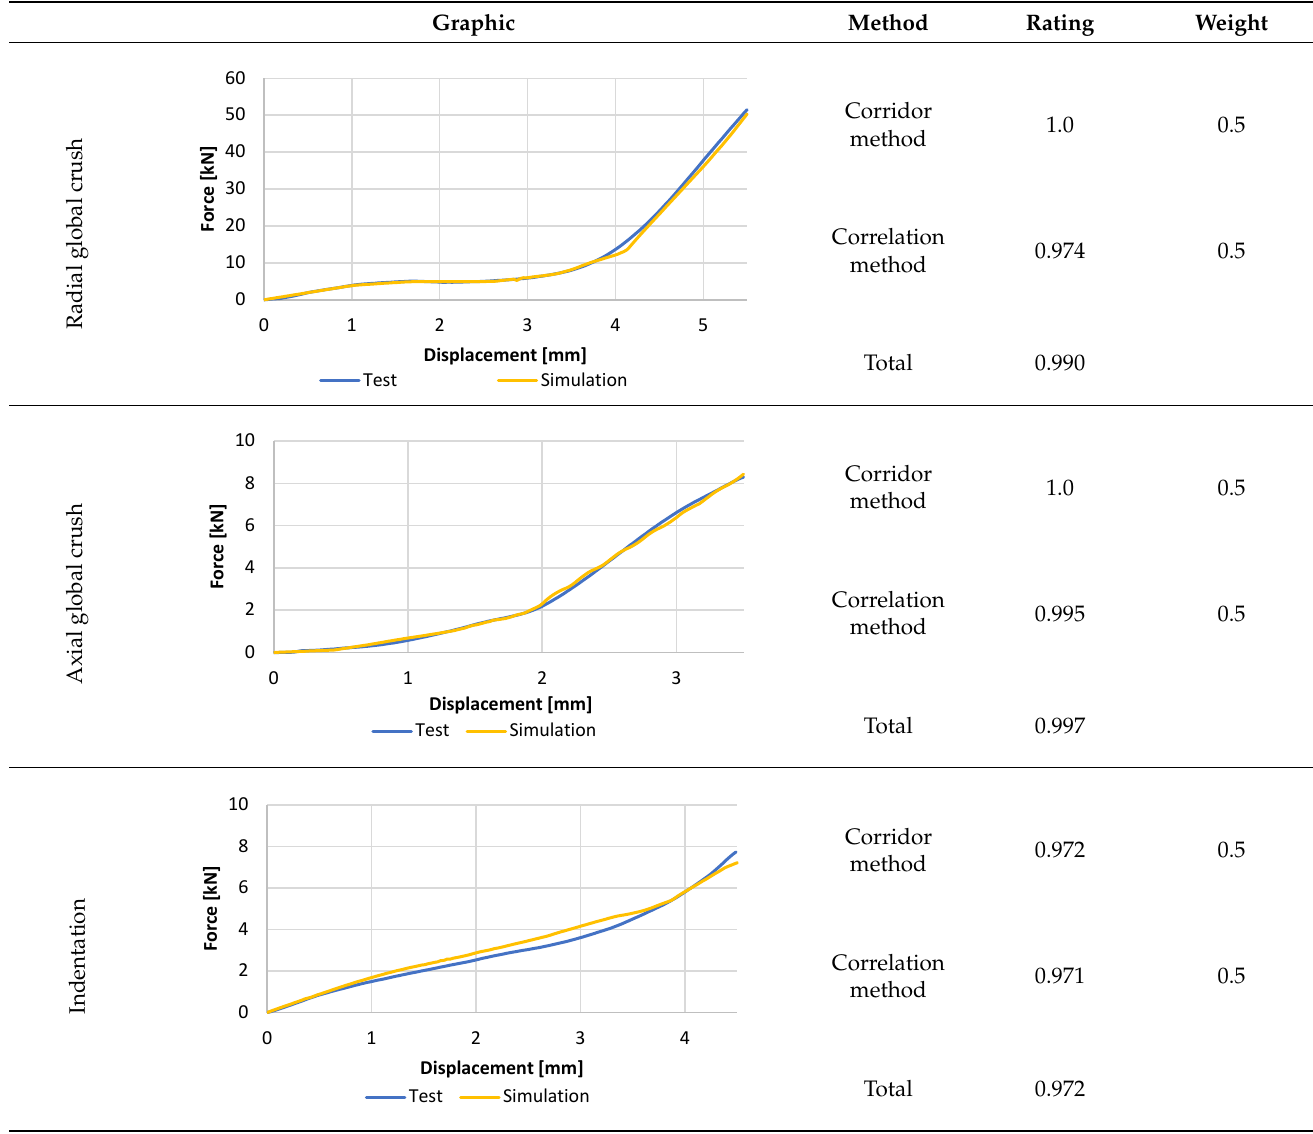
Table A2. Comparison of the force-displacement curves of the FE model and experimental tests for cell B and results of the CORA evaluation. Graphic Method Rating